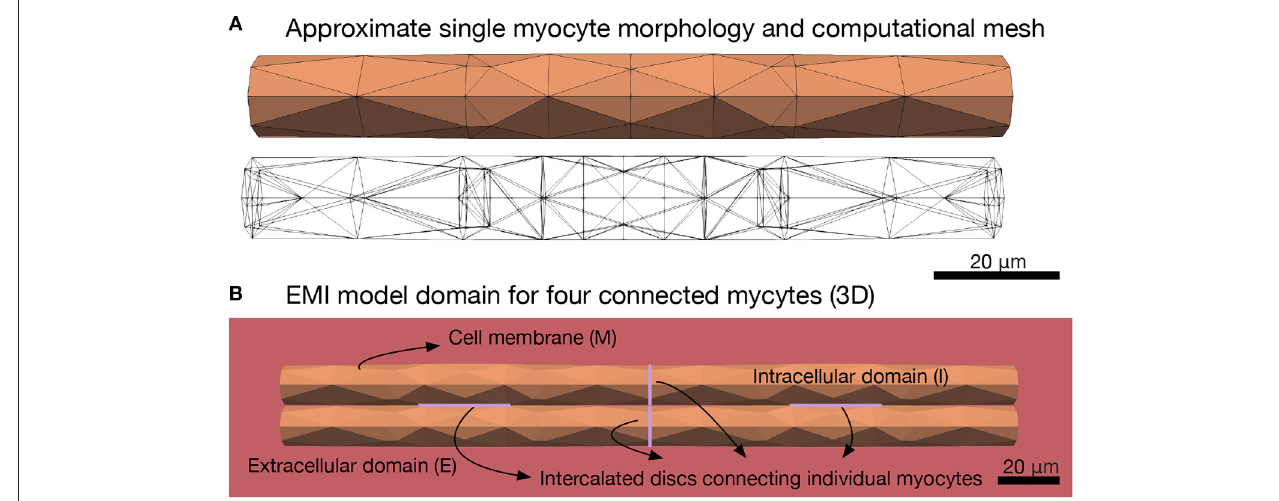
FIGURE 1 | Illustration of the EMI model domain. (A) Shows the approximate cylindrical geometry and associated mesh of a single myocyte of length 120 µ m and diameter ranging from 13 to 14 µ m ( Nygren et al., 1998). (B) Shows an illustration of the different components of the EMI model domain for an example collection of four connected myocytes. The domain consists of a number of myocytes surrounded by an extracellular space. The cell membrane is defined at the interface between the intracellular and extracellular spaces and intercalated discs with gap junctions are defined at the interface between adjacent myocytes. All computations presented here are in